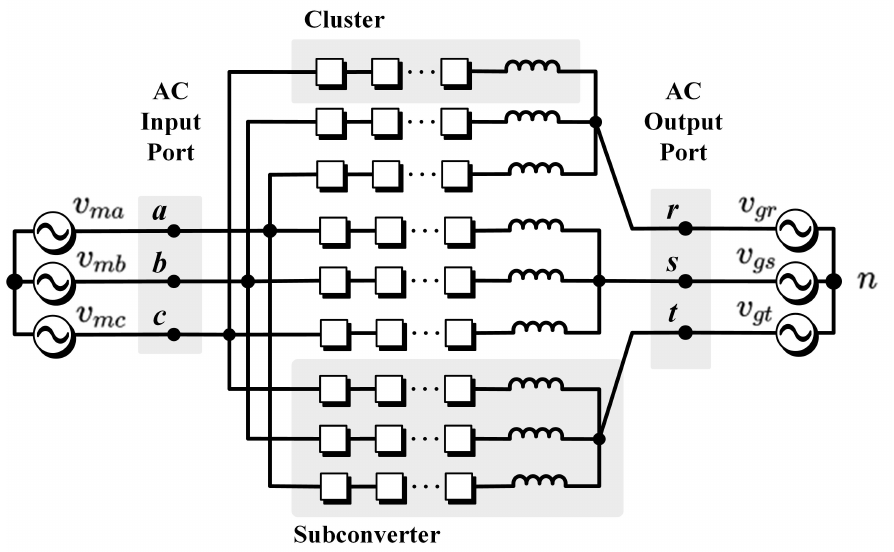
Figure 1. M 3 C topology. From